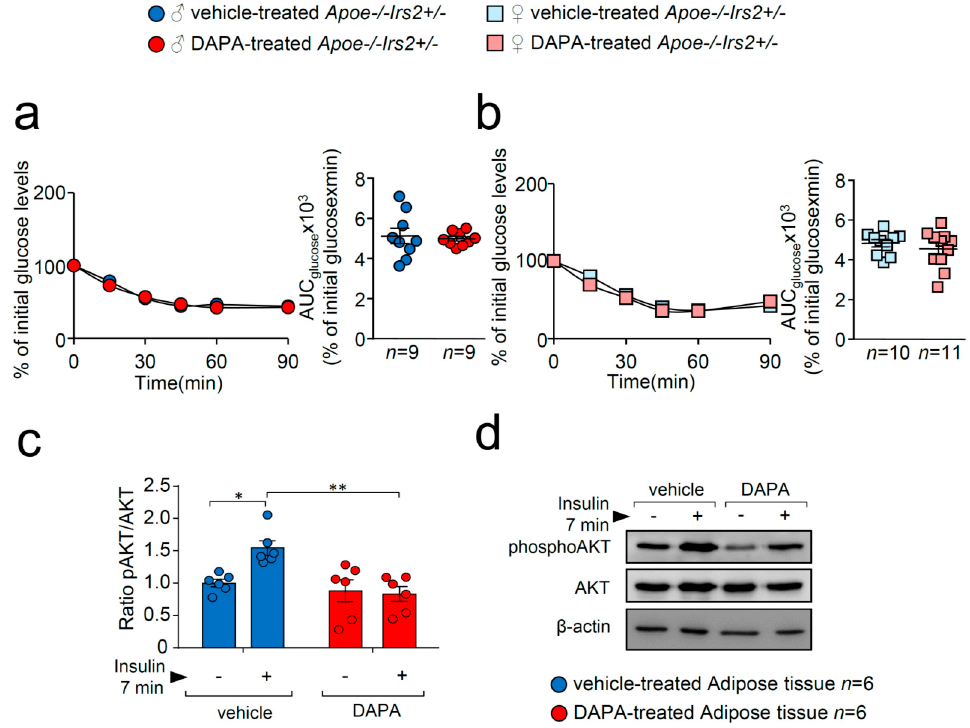
Figure 3. DAPA treatment effect on insulin sensitivity and signalling pathway. Glucose levels during the ITT and the corresponding AUC glucose in 4-hour-fasted ( a ) male and ( b ) female Apoe − / − Irs2 +/ − mice. ( c ) Quantification of phosphorylated(activated)-AKT1 / 2 (pAKT1 / 2) / AKT1 / 2 ratios in insulin-stimulated adipose tissue explants pretreated with vehicle or DAPA 1 µ M. β -actin is shown as a sample loading control. Phosphorylated forms were normalised to total protein levels and were relativised to the unstimulated sample. ( d ) Representative blots are depicted on the right of the quantification. Statistical analysis tests for normal distribution were the D’Agostino–Pearson omnibus ( a , b ) and Kolmogorov–Smirnov test ( c ) and for di ff erences, the Student’s t -test ( a , b ) and two-way ANOVA followed by Tukey’s multiple comparison test ( c ). * p < 0.05; ** p < 0.01.